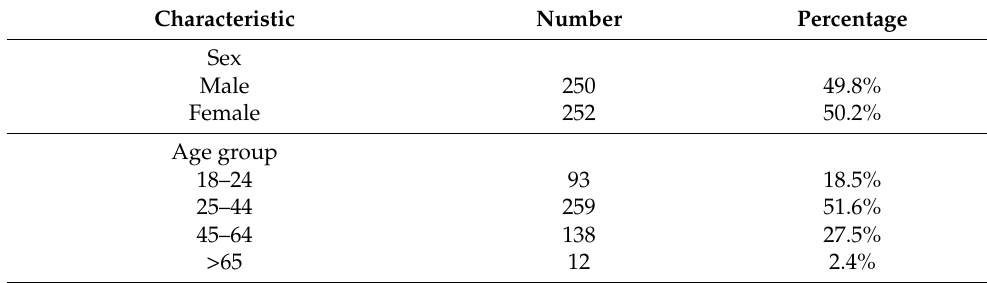
Table 1. Demographic characteristics of the study